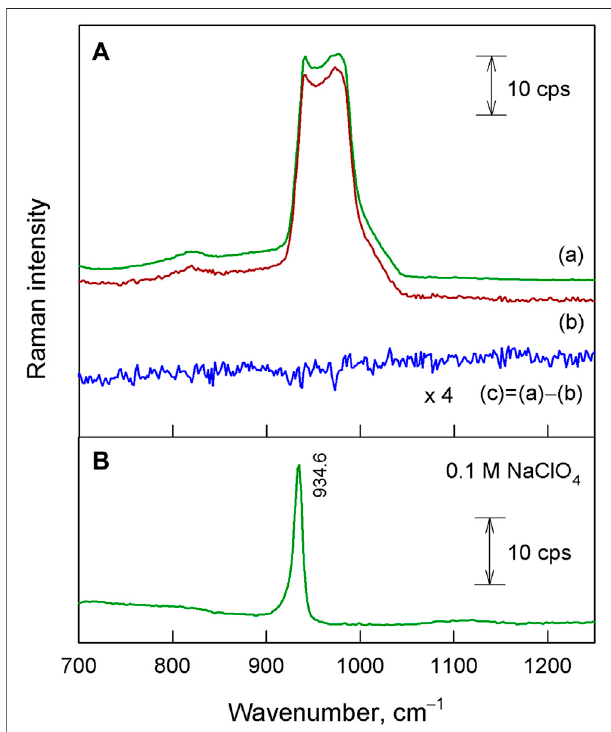
FIGURE 4 | (A) Raman spectra of Si – HfO 2 treated with radiation in NaClO 4 solution (a) and Sireferencesample(b). Difference spectrum(c) witha magni fi ed intensity (×4) is also shown. Spectra are shifted vertically for clarity. (B) Raman spectrum of 0.1 M NaClO 4 aqueous solution. Excitation wavelength is 532